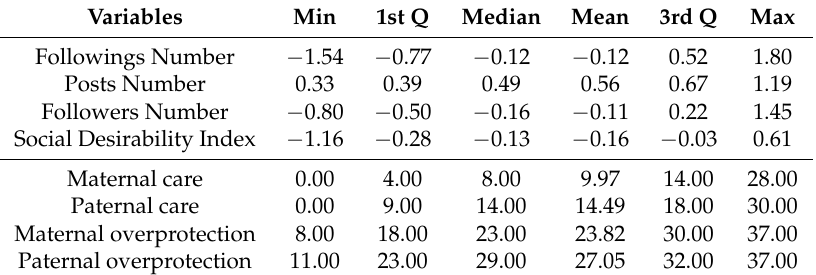
Table 2. Summary of the descriptive statistics for each continuous variable. The distribution of each variable is described in terms of the Minimum (Min), first Quartile (1st Q), median, mean, third Quartile (3rd Q), and Maximum values